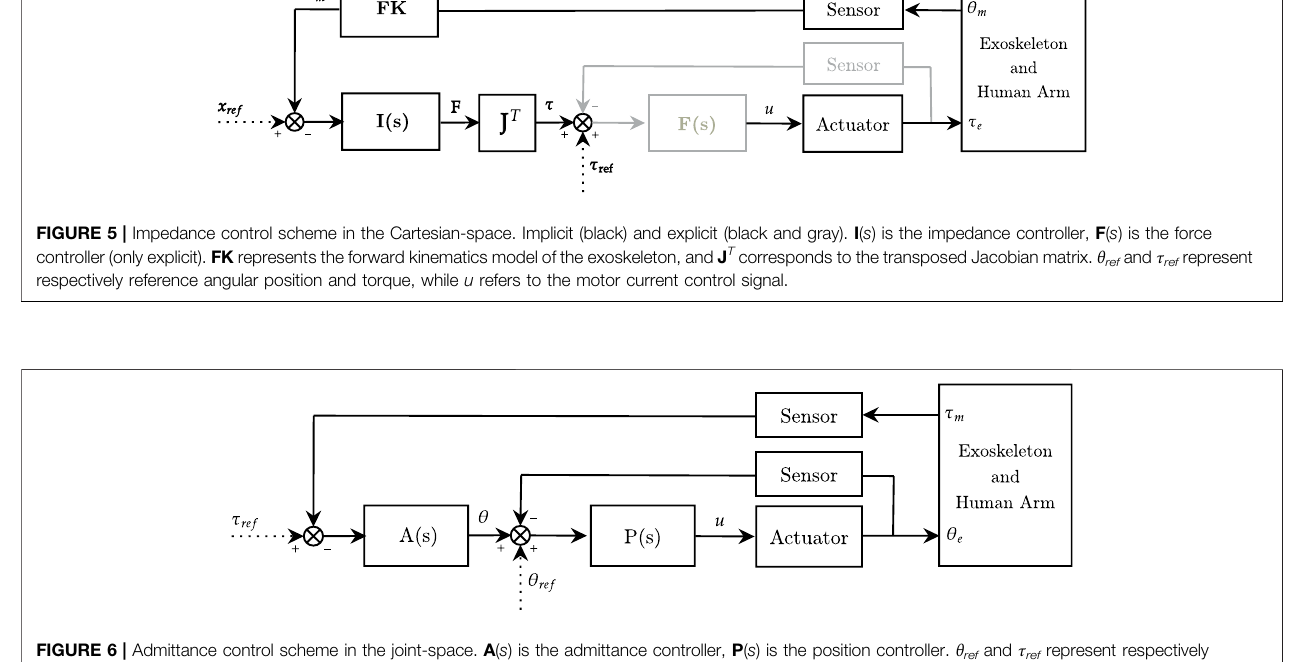
Frontiers in Robotics and AI |